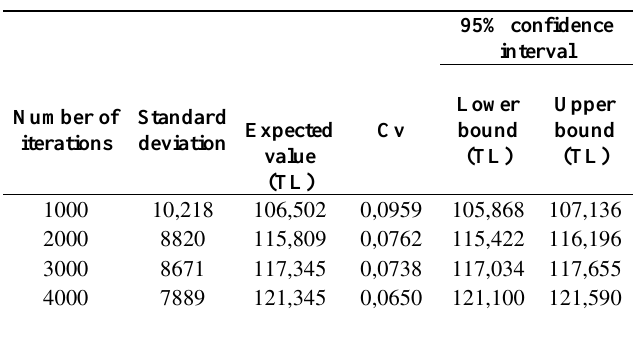
Table 1. Results for Convergence Analysis